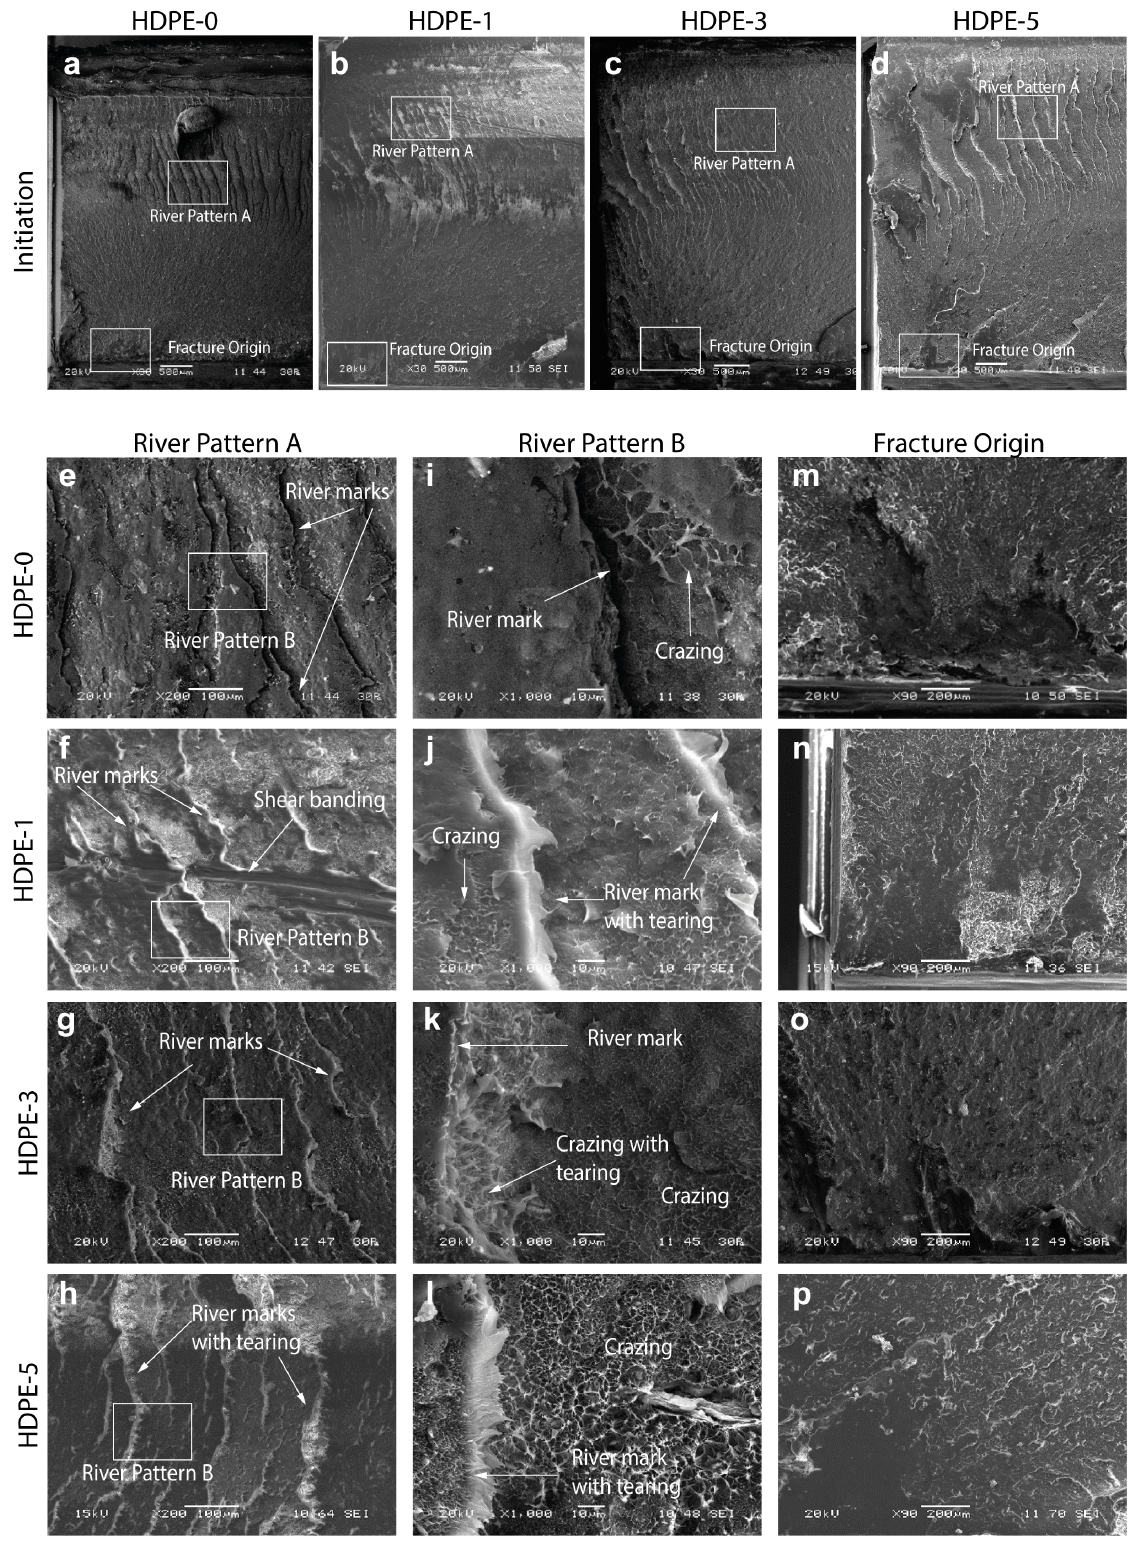
Figure 4. SEM images of the ( a – d ) initiation zone during RCP in the HSDT test specimens for different HDPE–clay nanocomposites (containing 0, 1, 3, and 5 wt% of nanoclay, respectively), and magnifications at ( e – h ) river pattern A, ( i – l ) river pattern B, and ( m – p ) the fracture